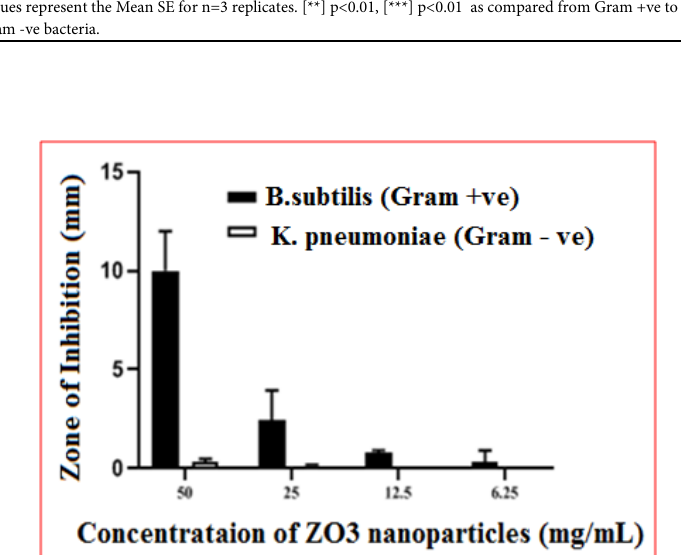
Fig. 11. The zone inhibition measured plot of different concentrations of ZO3 nanoparticles.